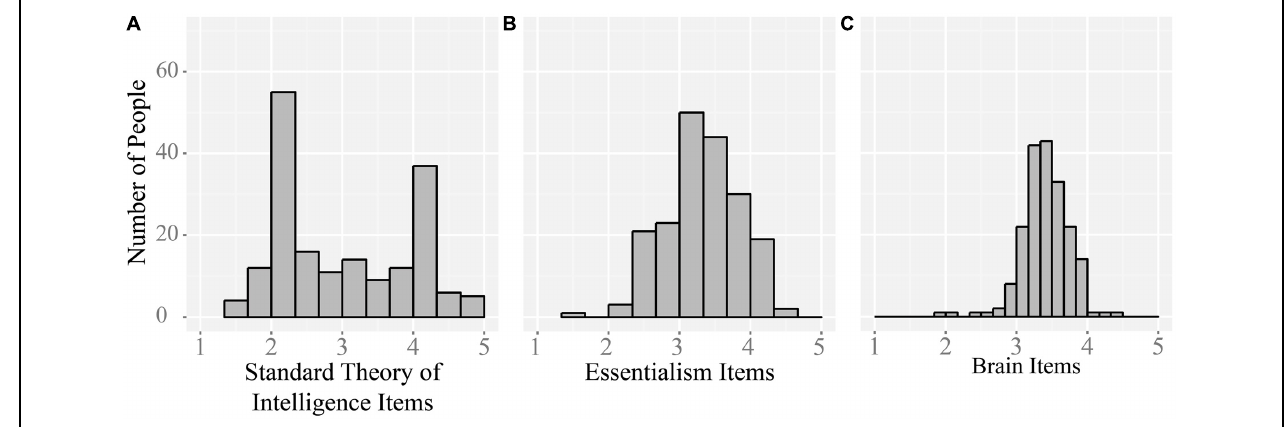
FIGURE 3 | Distributions. Histograms of averaged responses for the three standard TOI assessment items (A) ; the eight essentialism items (B) and the 26 brain items (C) . Only (A) shows a strongly bimodal distribution, indicating that theories of intelligence only appear categorical when assessed using the three